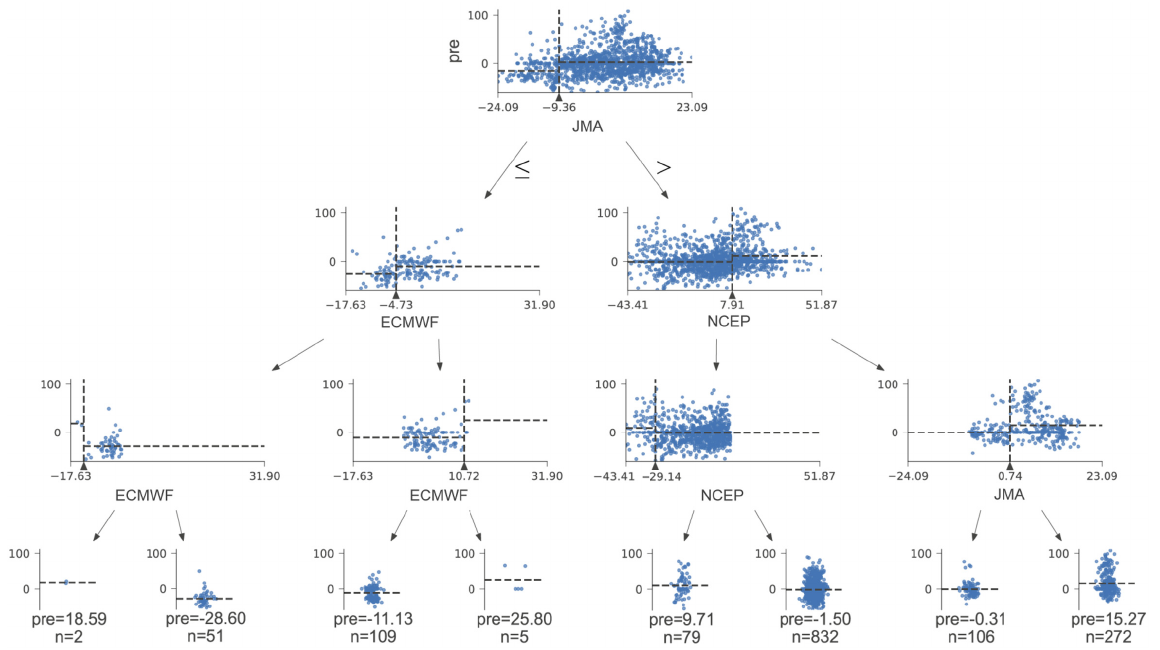
Figure 5. The decision tree structure with a maximum depth of three for summer precipitation prediction in eastern China.The dotted vertical line represents the value of node splitting and the dotted horizontal line represents the mean value of all points in the region.